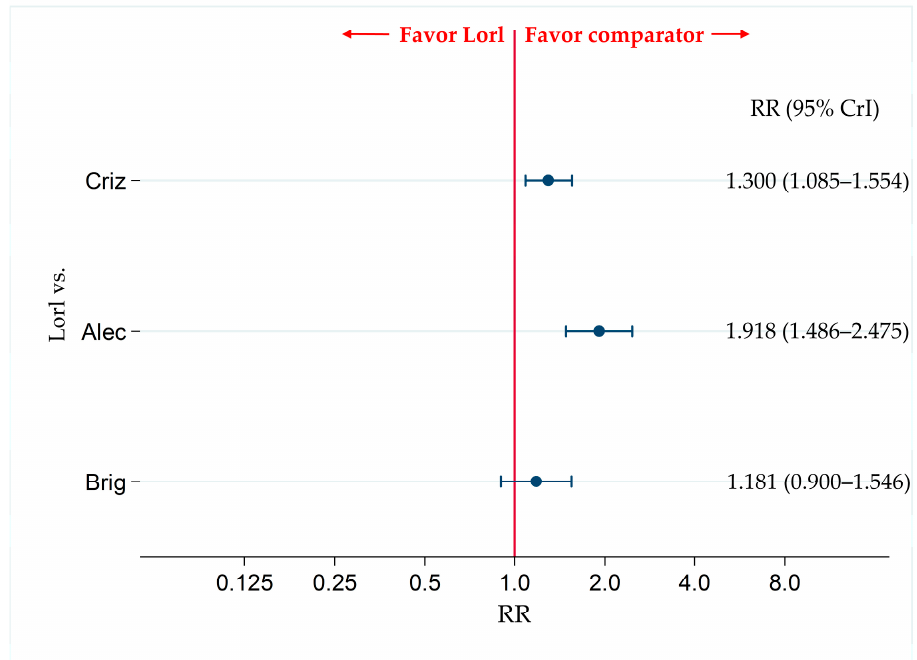
Figure 8. Comparative safety of G3-AEs with lorlatinib and the existing therapeutic agents for ALK-p ALK-inhibitor-naïve advanced NSCLC. Comparison of safety by assessing G3-AEs for ALK-p ALK-inhibitor-naïve advanced NSCLC between lorlatinib and each of the three other therapeutic agents including crizotinib, alectinib, and brigatinib as comparator are presented. Comparisons are expressed as lorlatinib versus each of the comparator agents. Data are expressed as risk ratios (RRs) and 95% credible intervals (CrIs) G3-AEs, grade 3 or higher adverse events; ALK, anaplastic lymphoma kinase; ALK-p, anaplastic lymphoma kinase-positive; NSCLC, non-small cell lung cancer; Lorl, lorlatinib; Brig, brigatinib; Alec, alectinib; Criz, crizotinib.